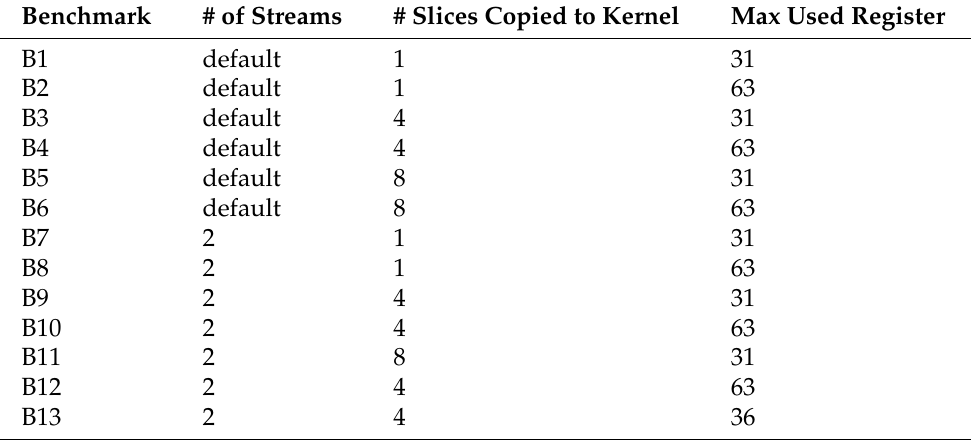
Table 1. Benchmarks types. Asynchronous memory copy is enabled when two streams are activated.